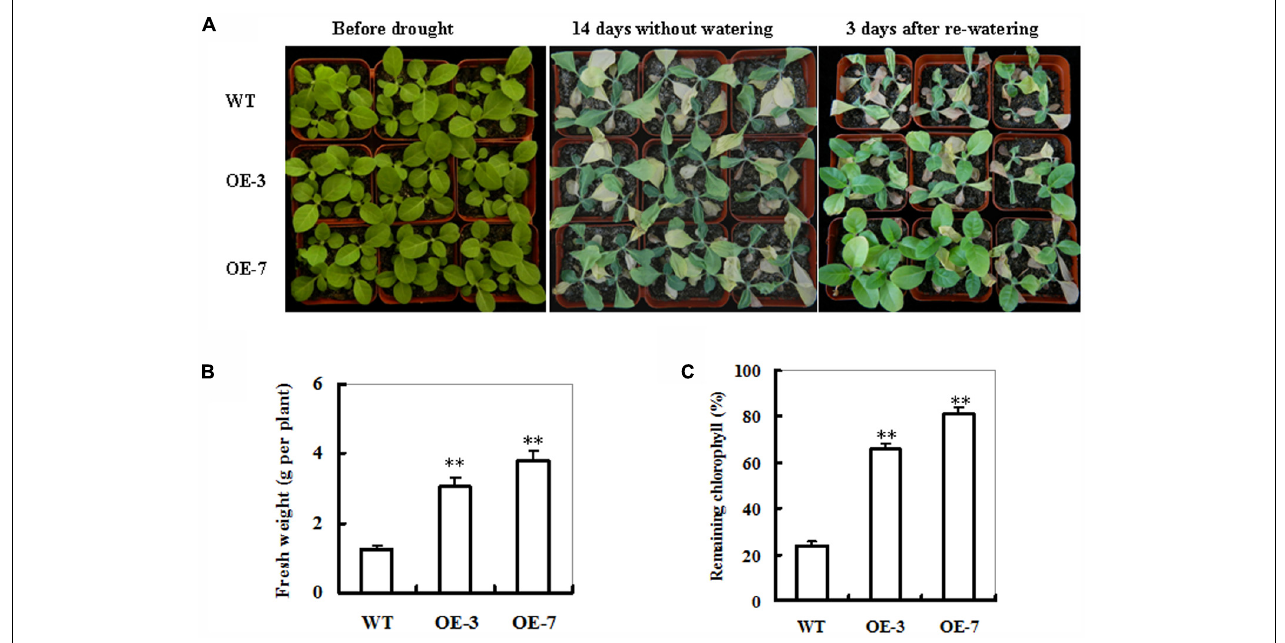
FIGURE 2 | Phenotypes of wild-type (WT) and ZmSO -overexpressing tobacco plants in response to drought stress. (A) Drought tolerance of potted plants of WT and ZmSO -overexpressing (OE) tobacco. Four-week-old WT and transgenic lines (OE-3 and OE-7) were grown in soil in pots for 14 days without watering, and then re-watering for 3 days. (B) Fresh weight of 14-day-drought-stressed WT and ZmSO- OE plants after 3 days recovery. Values are mean ± SE, n = 12. ∗∗ t -test, with P < 0.01. (C) Relative remaining chlorophyll (%) in 14-day-drought-stressed WT and ZmSO -OE plants. Values are mean ± SE, n = 12. ∗∗ t -test, with P < 0.01.